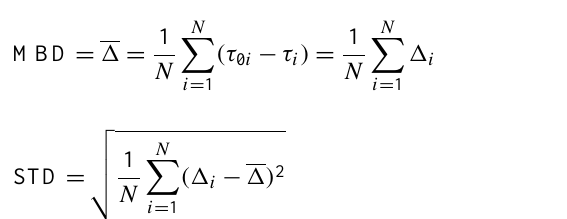
Fig. 2. Evolution of daily averaged differences between ESR- CIMEL (mode 1) and AERONET products in Burjassot during period 2007–2011: (a) AOD at 675nm, (b) AOD at 1020nm, (c) ˚Angstr¨om exponent, and (d) columnar water